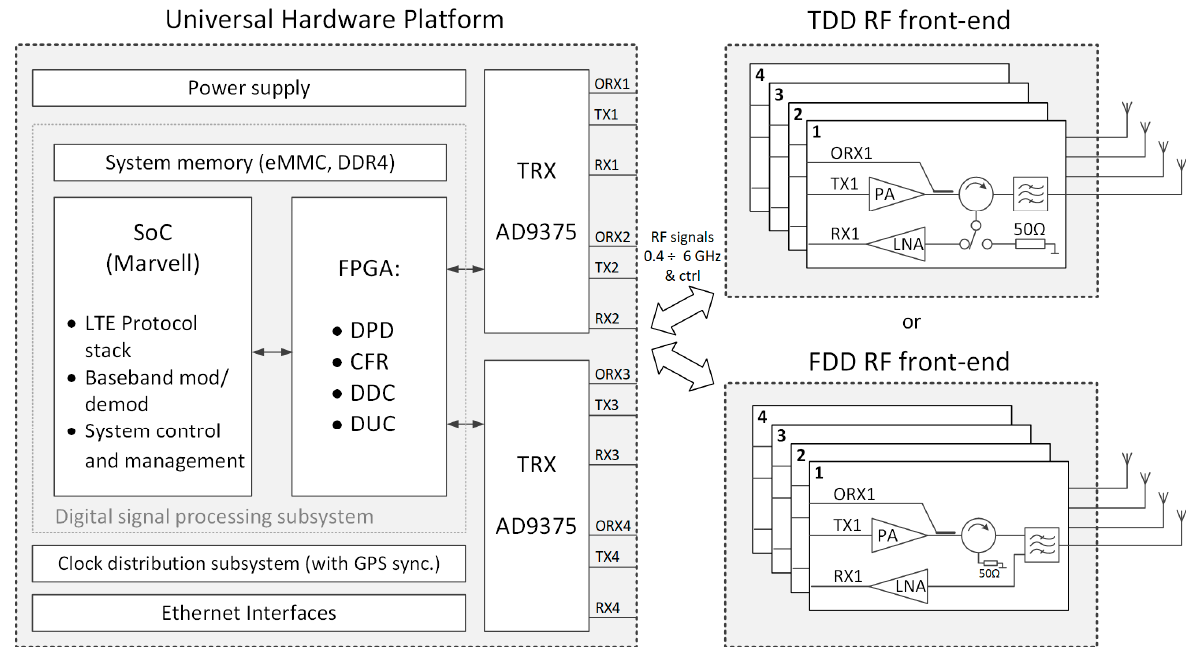
Figure 2. Block diagram of the Universal Hardware Platform architecture.